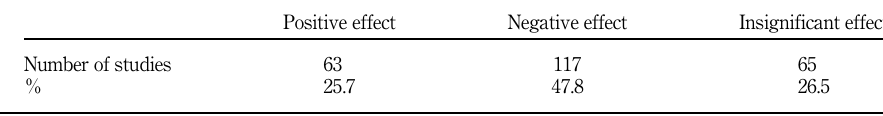
Table 7. Descriptivestatisticsof beta coefficients for the effect of capital